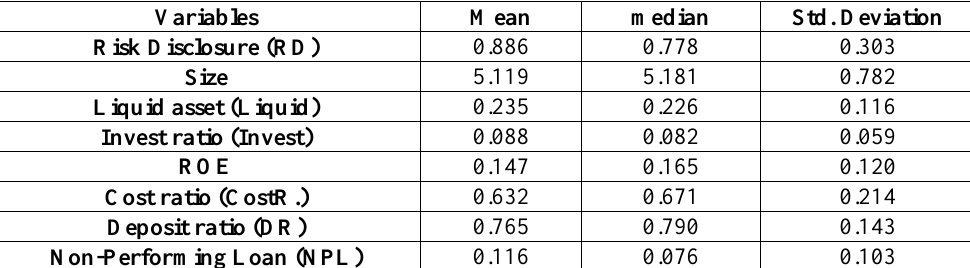
Table 3. Descriptive